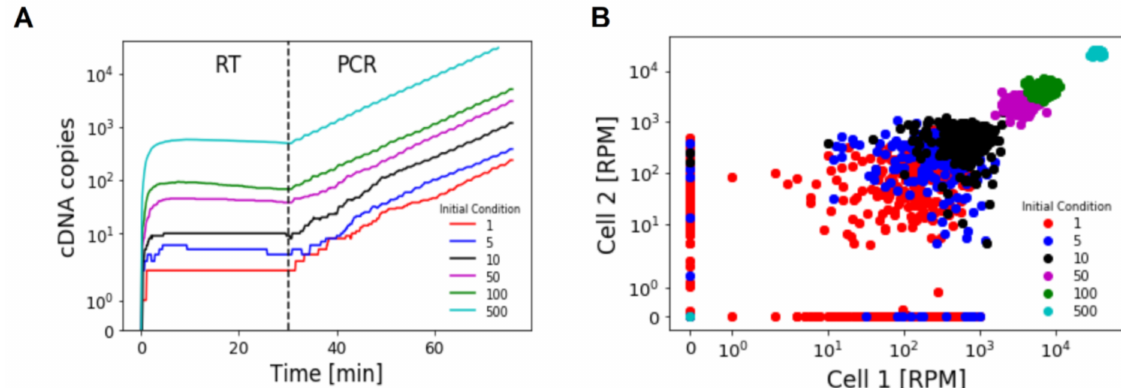
Figure 3. Simulation results. ( A ) Numerical solution of CME for the number of cDNA copies (Equation (4)) considering the RT, and PCR phases, the simulation time was 76 min. Each color line stands for a different initial RNA count before the RT-PCR process. ( B ) Scatter plot of cDNA copies for two cells that have the same CMEs. For each condition, we performed 200 realizations; the plotted value is the last for the number of cDNA copies at 76 min. The different colors are the initial cDNA count for every point. The expression values for the transcripts are in reads per million